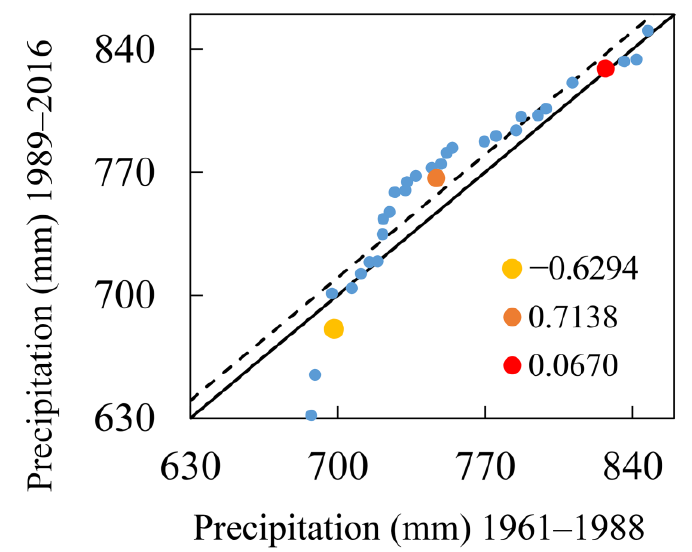
Figure 3. Illustration of the innovative trend analysis (ITA) method. The solid line is the no-trend (1:1) line and the dashed line is the data line. Yellow, orange, and red points denote the mean central points of the low, medium, and high categories, respectively.